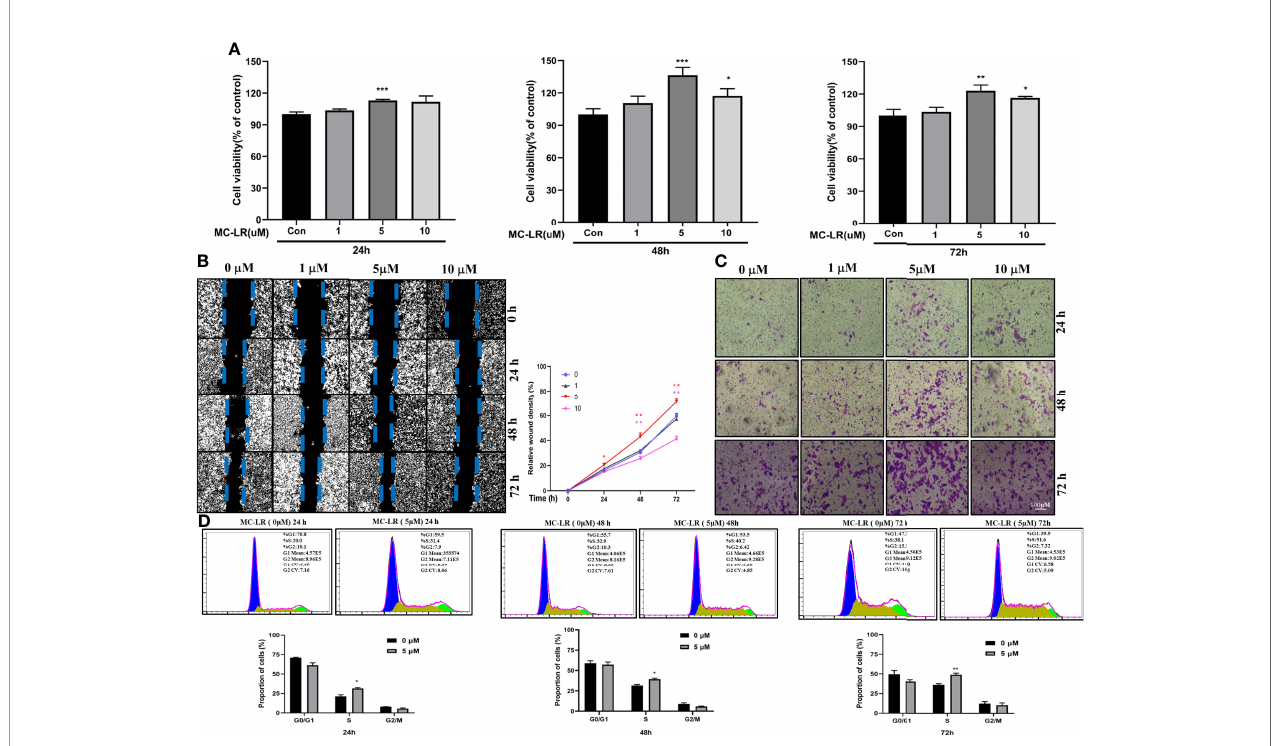
FIGURE 8 | Caco2 cell proliferation, migration and cell cycle progression induced by MC-LR. (A) Cell viability of Caco-2 cells exposed to 1, 5, and 10 µM MC-LR for 24, 48, or 72 h. The control cells were cultured with 0.1% DMSO n=4. (B) The migration of Caco2 cells treated with 1, 5, and 10 µM MC-LR for 24, 48, or 72 h by Wound healing assay. n=3. (C) The images of the transwell assay results. Scale bar: 100 µm. (D) High cell proportion in S phase of the MC-LR-treated group. * P <0.05, ** P <0.01 and *** P <0. 0.001 vs. the control